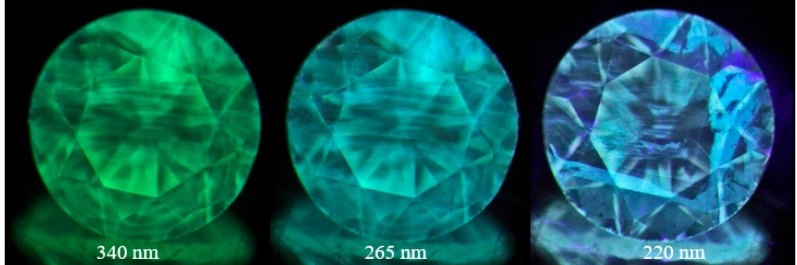
Figure 29. A light yellowish brown near type IIa diamond (sample TH 2.616) under three different UV excitations of the DFI system. The green PL is caused by the 490.7 nm and H4 defects, the blue PL by the 406.1 nm and the N3 defects.